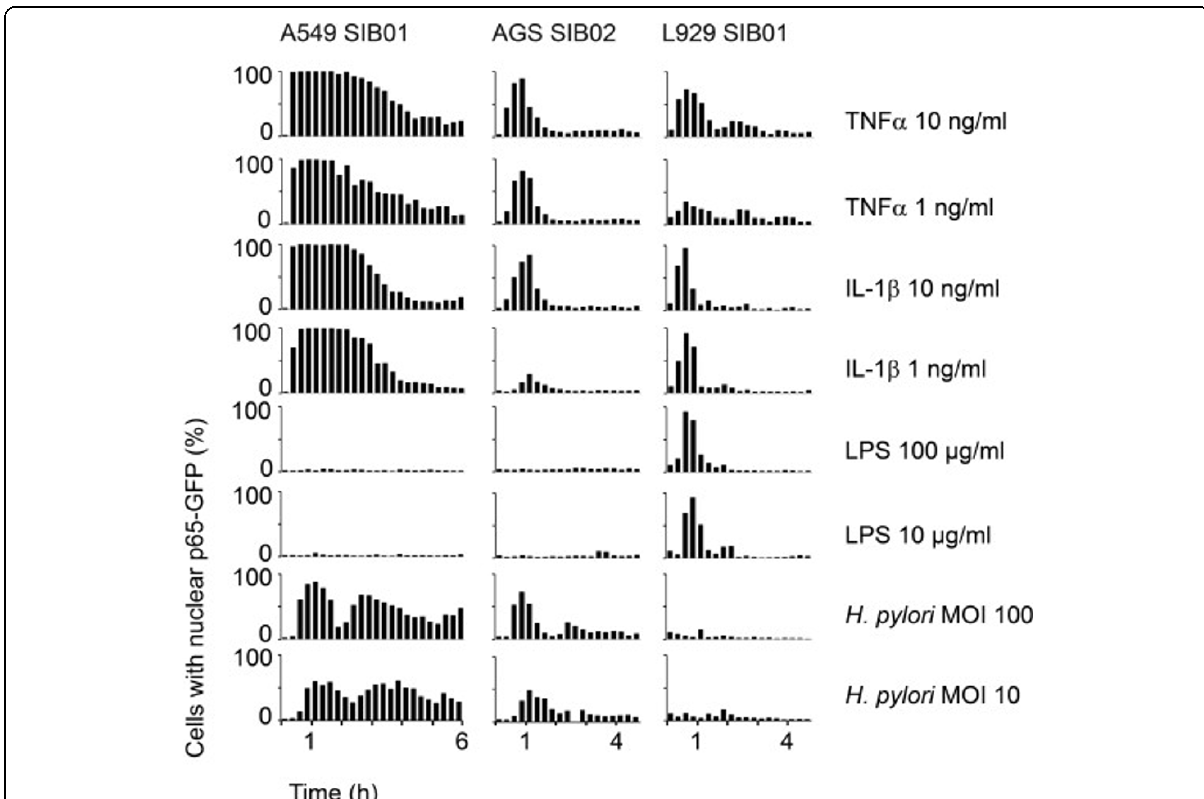
Figure 3 Inducer-specific activation profiles of cell lines A549 SIB01, AGS SIB02 and L929 SIB01 . The cell lines were activated with the indicated inducer for times between 0 and 6 h: A549 SIB01 was activated for 0-345 min, AGS SIB02 and L929 SIB01 for 0-270 min, each at intervals of 15 min. Cells were fixed, stained with Hoechst 33342 and then analyzed with automated microscopy and image analysis software. For each cell line, single cells were analyzed and the mean percentage of cells with nuclear p65-GFP per well was calculated as described in Figure 2. Mean percentages from duplicate experiments are shown as bars. Results are representative of at least three independent experiments. Standard deviations are not shown for graphical reasons. One data point is missing in AGS H. pylori MOI 10 due to technical